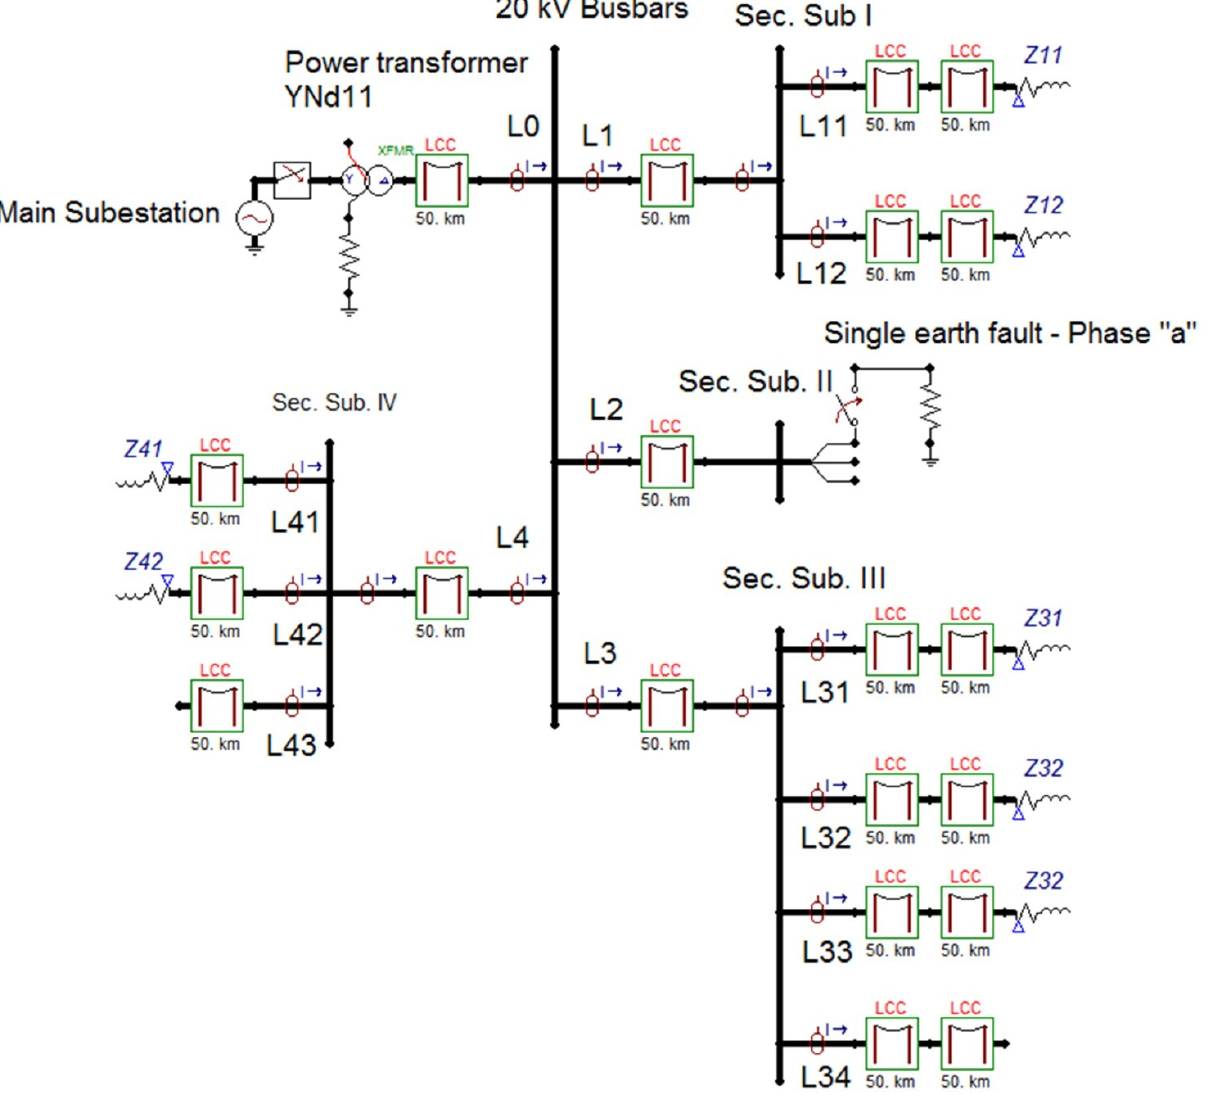
Figure 14. Single line diagram for main and secondary